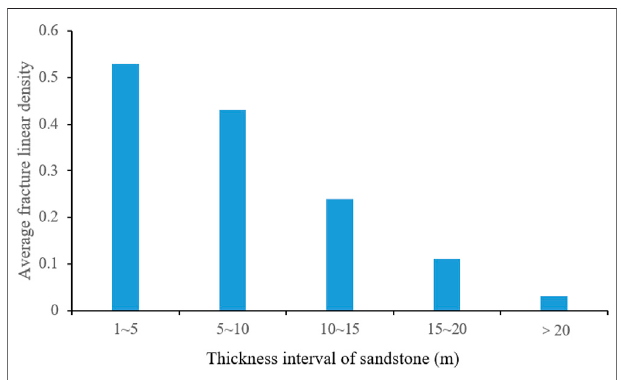
FIGURE 6 | Relationship between the thickness of fractured sand bodies and the thickness of single-layer sandstone in the Chang 6 and Chang 8 oil layer groups in the study area.